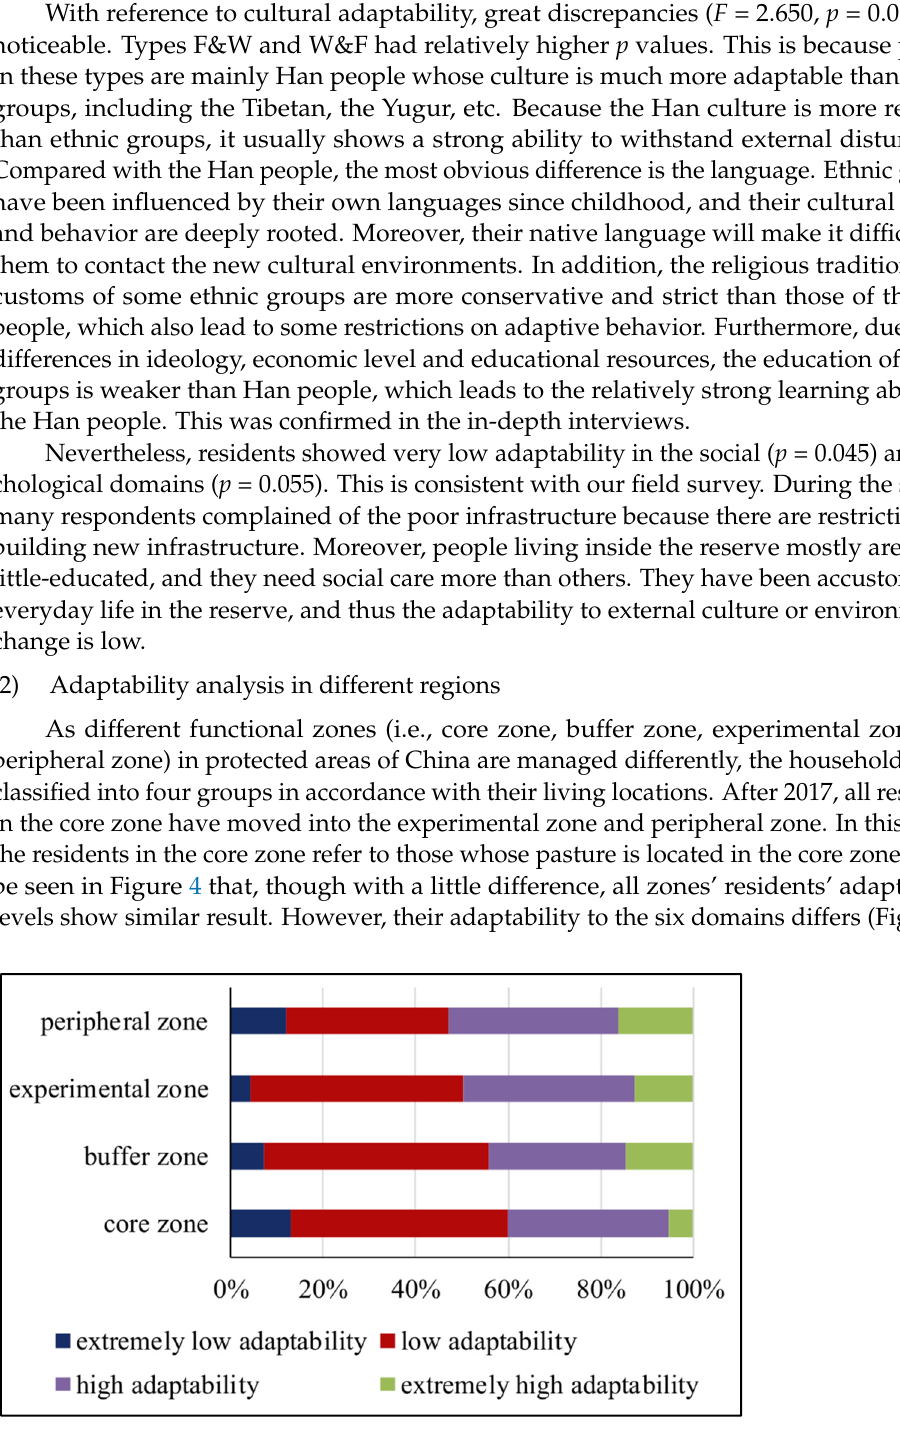
Figure 4. Adaptability of residents in different functional zones.